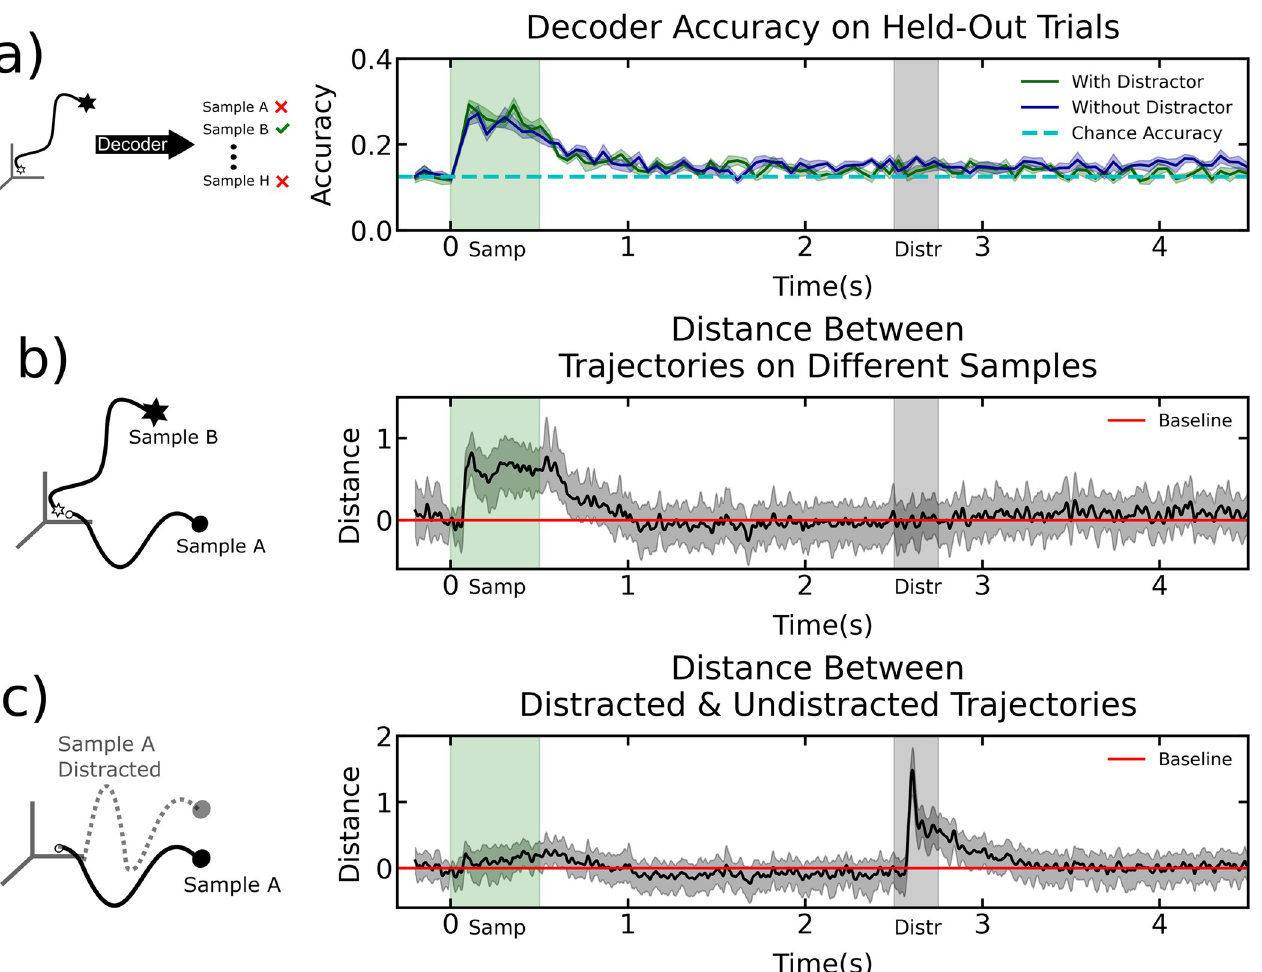
Fig 2. a) Left: training a decoder to predict sample identity given a neural trajectory. Right: decoder accuracy on held-out trials for distracted vs. undistracted trials b) Left: comparing trial-averaged trajectories corresponding to different samples. Right: average pairwise distance in state-space between trajectories elicited by all possible sample images. Normalized by the average pre-stim distance. c) Left: comparing trial-averaged distracted vs. non-distracted trajectories through neural state space. Right: distance in state space between distracted vs. non-distracted trajectories throughout the trial. Shown are trials with a delay of four